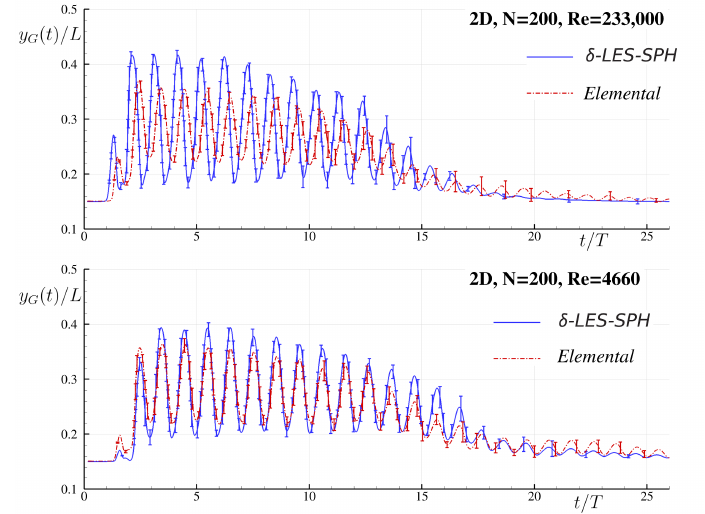
Figure 33. Time history of the vertical position of the fluid center of mass y G ( t ) evaluated by the SPH-Flow and Elemental solvers in a 2D framework. The 2D results are given by an ensemble average of ten simulations. Error bars refer to the computed standard deviation. ( Top ) water test-case. ( Bottom ) oil test-case.